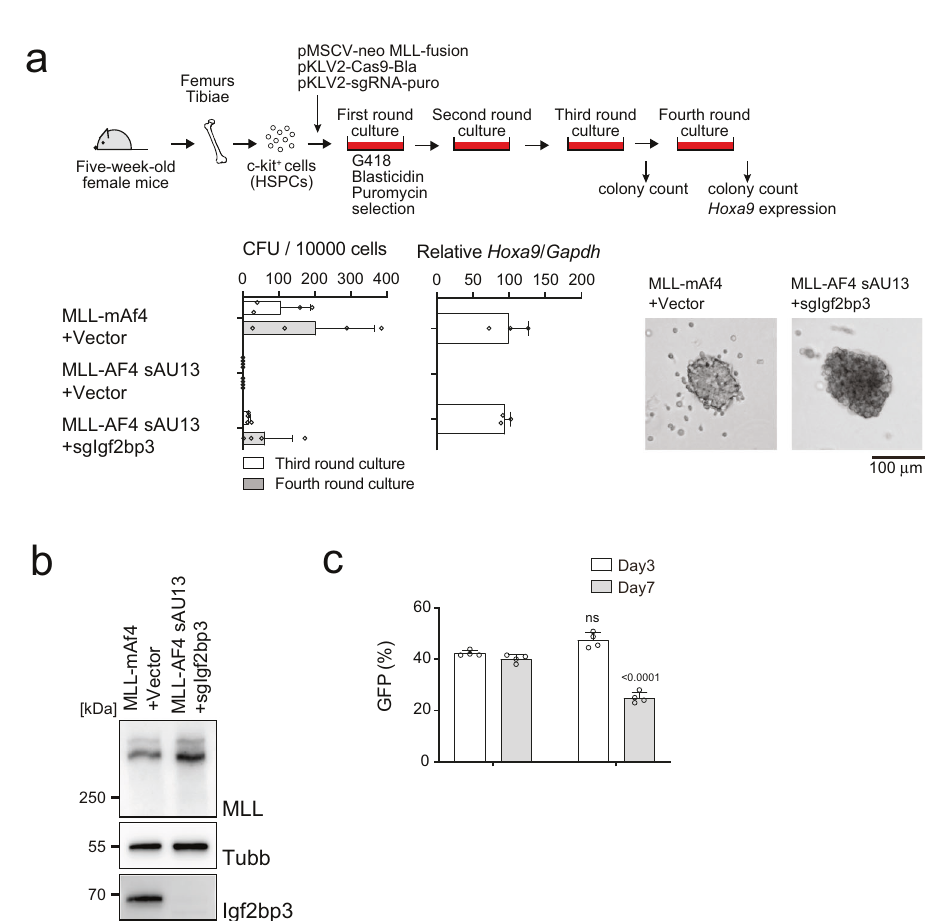
Fig. 4 | Unique RNA-binding proteins speci fi cally bind to RNA containing the PTRS. a Silver staining of puri fi ed factors associated with the minimum PTRS of AF4 . b Heatmapofproteinsco-puri fi edwiththePTRSRNAswiththerelativescores. Proteins wereidenti fi edusing mass spectrometry. c Immunoprecipitation-western blotting of proteins associated with the PTRS RNAs using 293T cells transiently expressing FLAG-tagged proteins. d CISBP-RNA database analysis of the RNA sequencesspeci fi callyrecognizedbyvariousRBPsintheminimumPTRSof human AF4 (http://cisbp-rna.ccbr.utoronto.ca/index.php). The nucleotide bases in the three AU-rich sitesaremarkedinblue letters, whereasthe differentbases from the humansequenceinthethreeAU-richsitesareinred. e TransformingabilityofMLL- AF4 mutants. Various MLL-AF4 constructs carrying synonymous mutations on the AU-richsiteswereexaminedfortransformationofHSPCsunderanexvivomyeloid